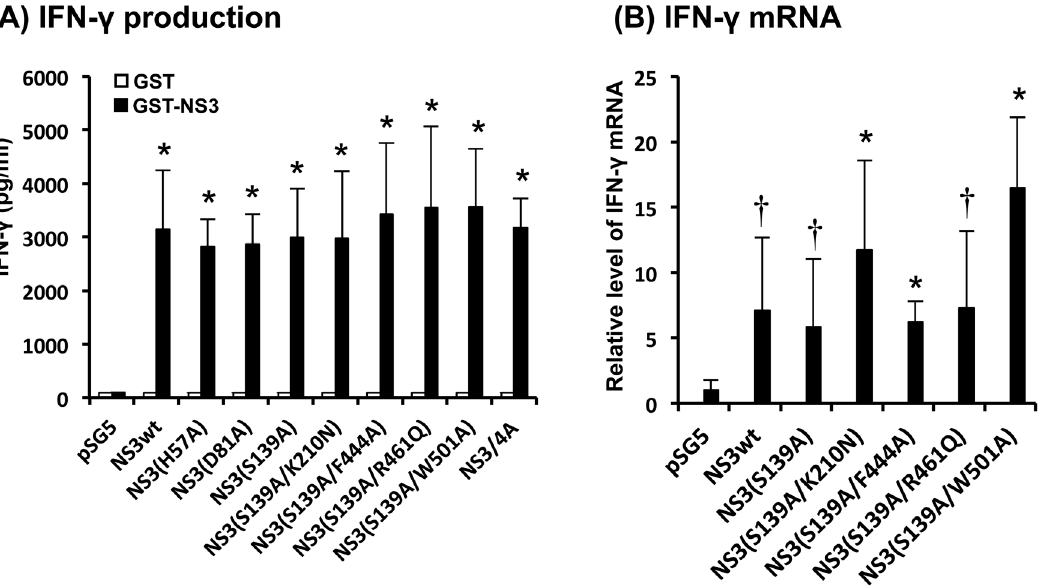
Figure 3. IFN- c production induced by NS3 DNA vaccination. (A) IFN- c production by splenocytes obtained from immunized mice. BALB/c mice (2 mice/group) were immunized with each of the DNA vaccines expressing NS3wt, various NS3 mutants or NS3/4A. Splenocytes obtained from the immunized mice were cultured in the presence of GST-NS3 (5 m g/ml) for 72 h. The amounts of IFN- c in culture supernatants were measured with ELISA. Data represent mean 6 SEM of the data from three independent experiments. *, p , 0.01 compared with the mock-immunized control. (B) IFN- c mRNA expression. Splenocytes obtained from immunized mice were cultured in the presence of GST-NS3 (5 m g/ml) for 24 h. The amounts of IFN- c mRNA were determined by real-time quantitative RT-PCR analysis and normalized to GAPDH mRNA expression levels. Data represent mean 6 SEM of the data from three independent experiments. The value for splenocytes from the mock-immunized control was arbitrarily expressed as 1.0. *, p , 0.01; { , p , 0.05, compared with the